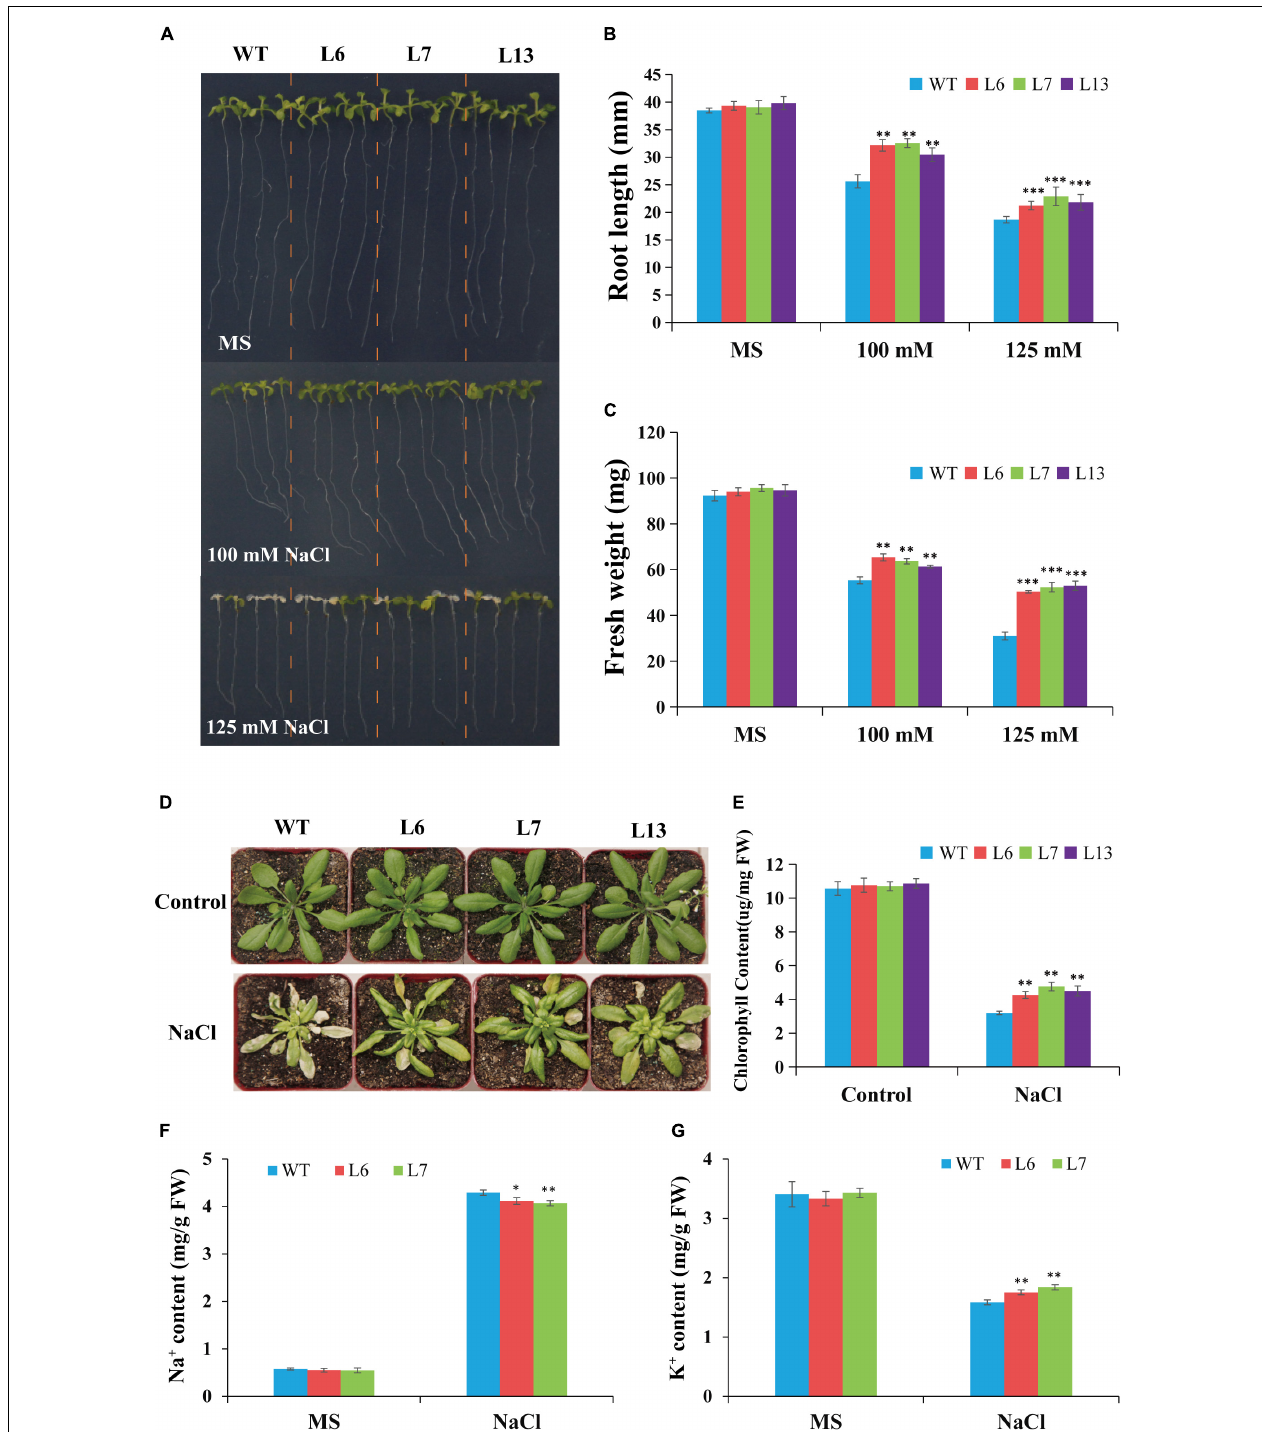
FIGURE 5 | Comparison of salt tolerance between wild type (WT) and transgenic lines. (A) Growth and development of the HbERF6 -overexpressing lines and WT seedlings under NaCl treatment and normal condition. (B,C) Root length and fresh weight of the 12-day-old seedlings on MS plates with and without salt were measured, respectively. (D) Representative photographs of potted plants of WT and overexpressing HbERF6 plants at 6th leaf stage which have been treated with 350 mM NaCl solution once in every 7 days for two times. After that, watering and culturing were performed for about 14 days. No treatment was set as control. (E) The chlorophyll content of overexpressing lines and WT was measured just after recording the phenotype in (D) . The Na + (F) and K + (G) contents of the 11-day-old transgenic and WT seedlings were measured under normal condition and salt stress (100 mM NaCl for 10 days). The experiments were repeated three times. Asterisks show that the difference in the values is significant between transgenic lines and the WT ( ∗ P < 0.05; ∗∗ P < 0.01; ∗∗∗ P < 0.001).